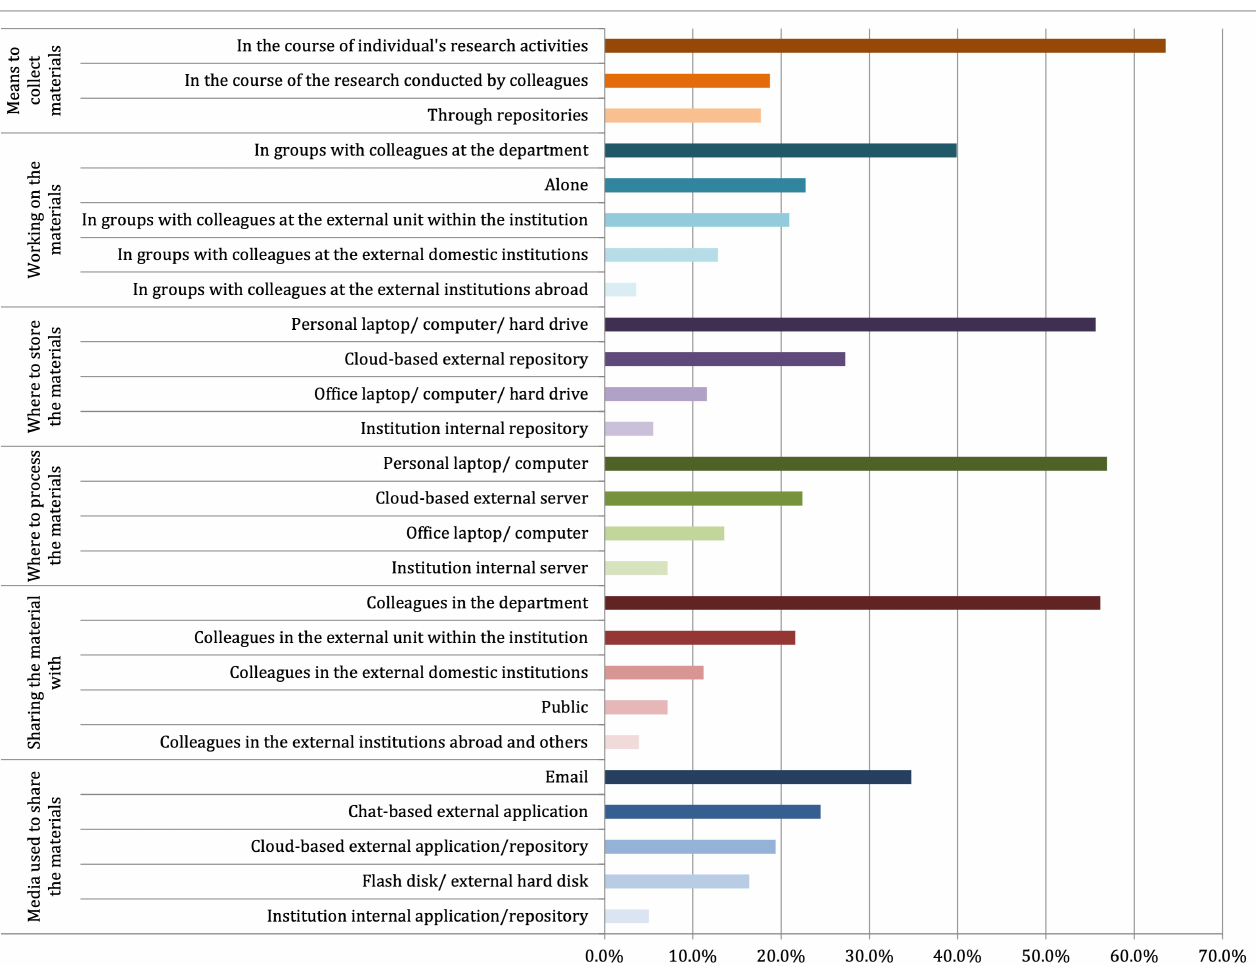
Figure 2. Indonesian scientists’ behavior in producing, storing, accessing, or sharing digital